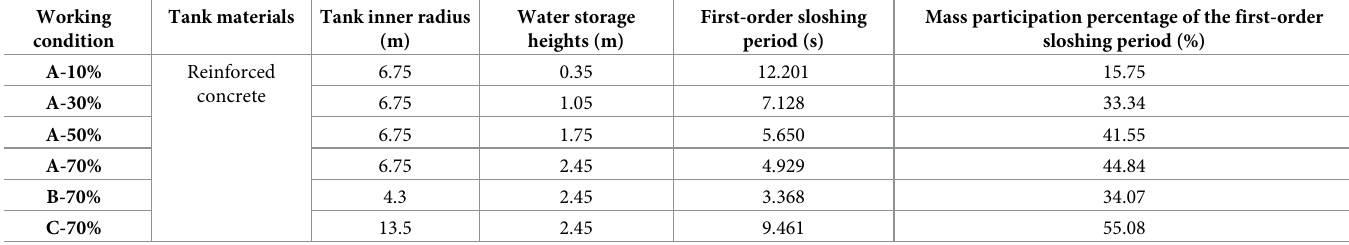
Table 7. Brief tank model features and dynamic characteristics